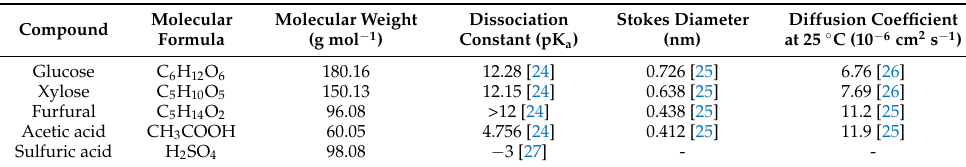
Table 1. Physical properties of compounds in the model